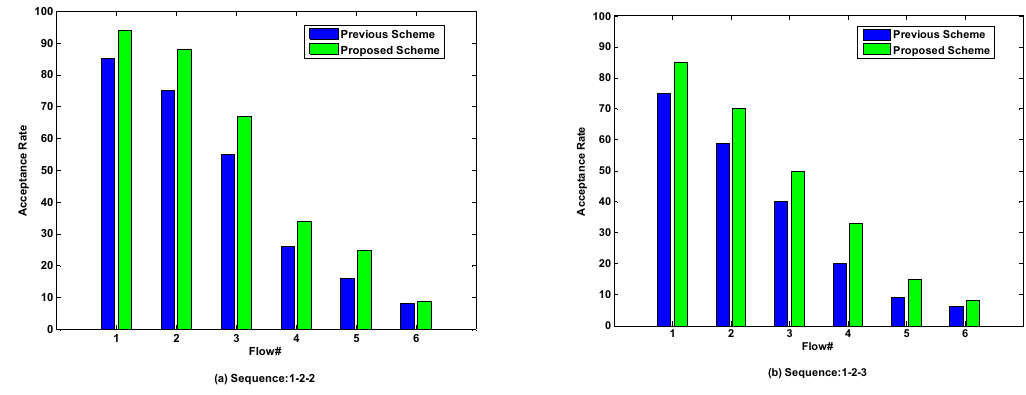
Figure 8. Simulation results for w.r.t IntraRecv time slots.